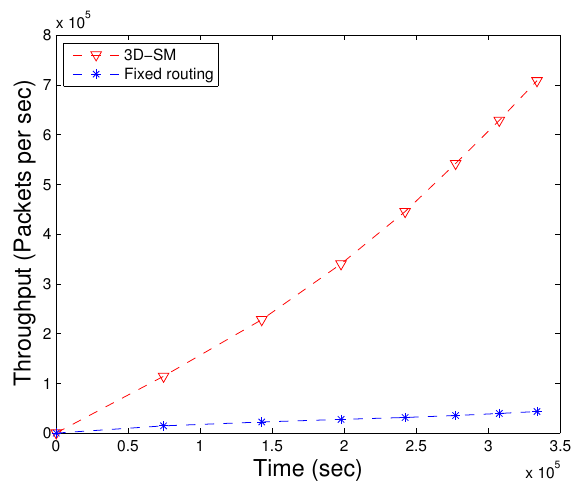
Figure 21. Throughput of fixed and dynamic routing.